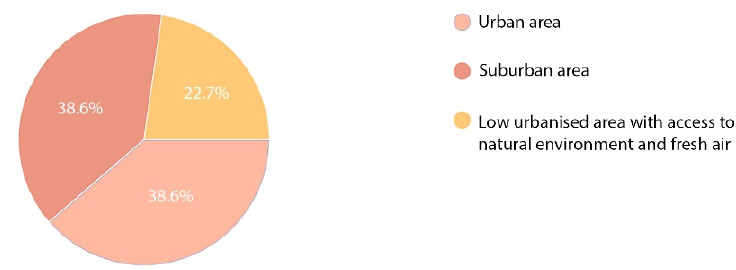
Figure 15. Preferred location of a hospital—staff.